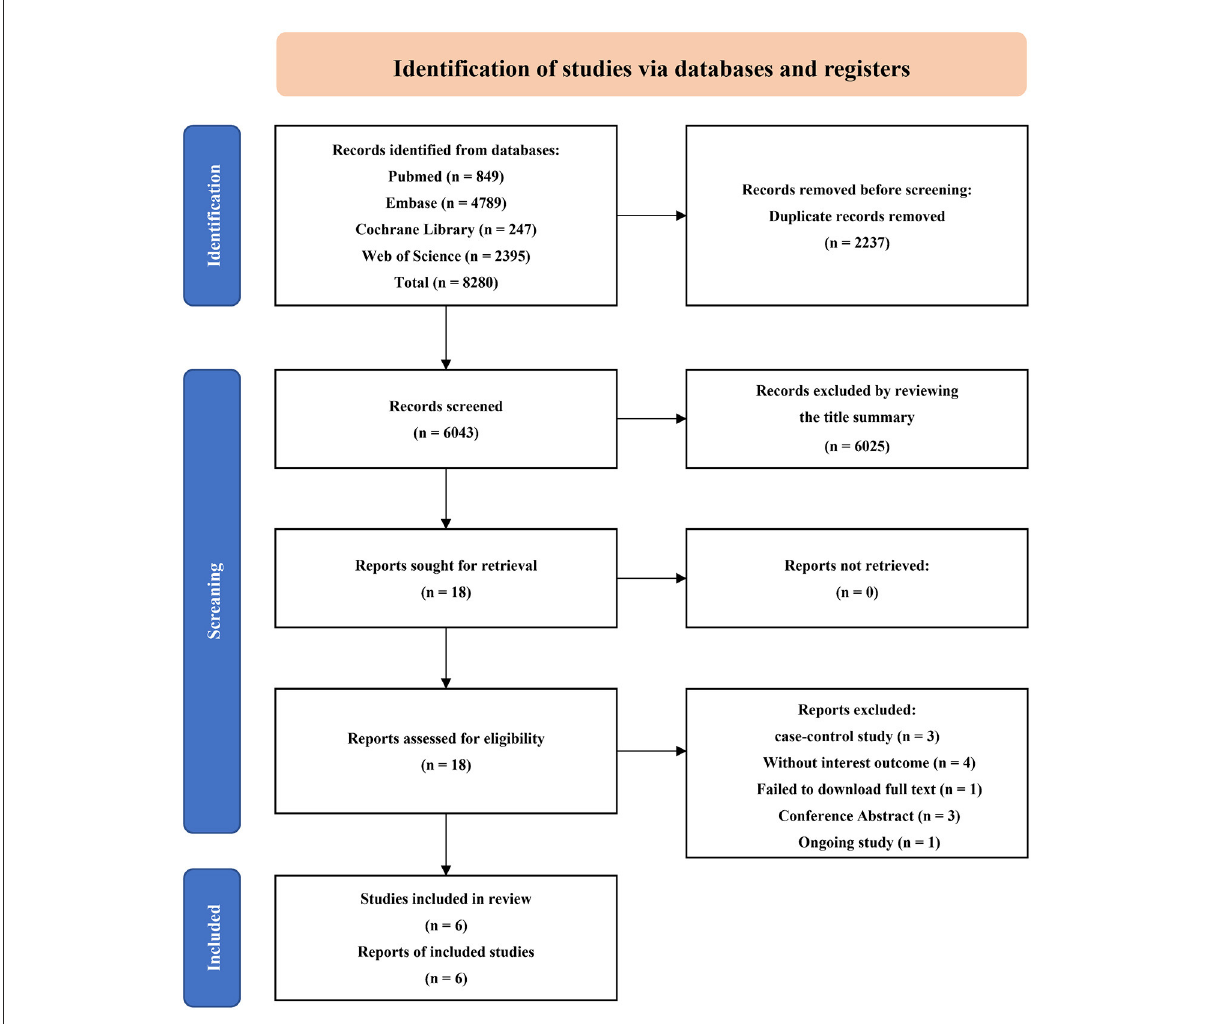
FIGURE1 Flowchart of literature search and study